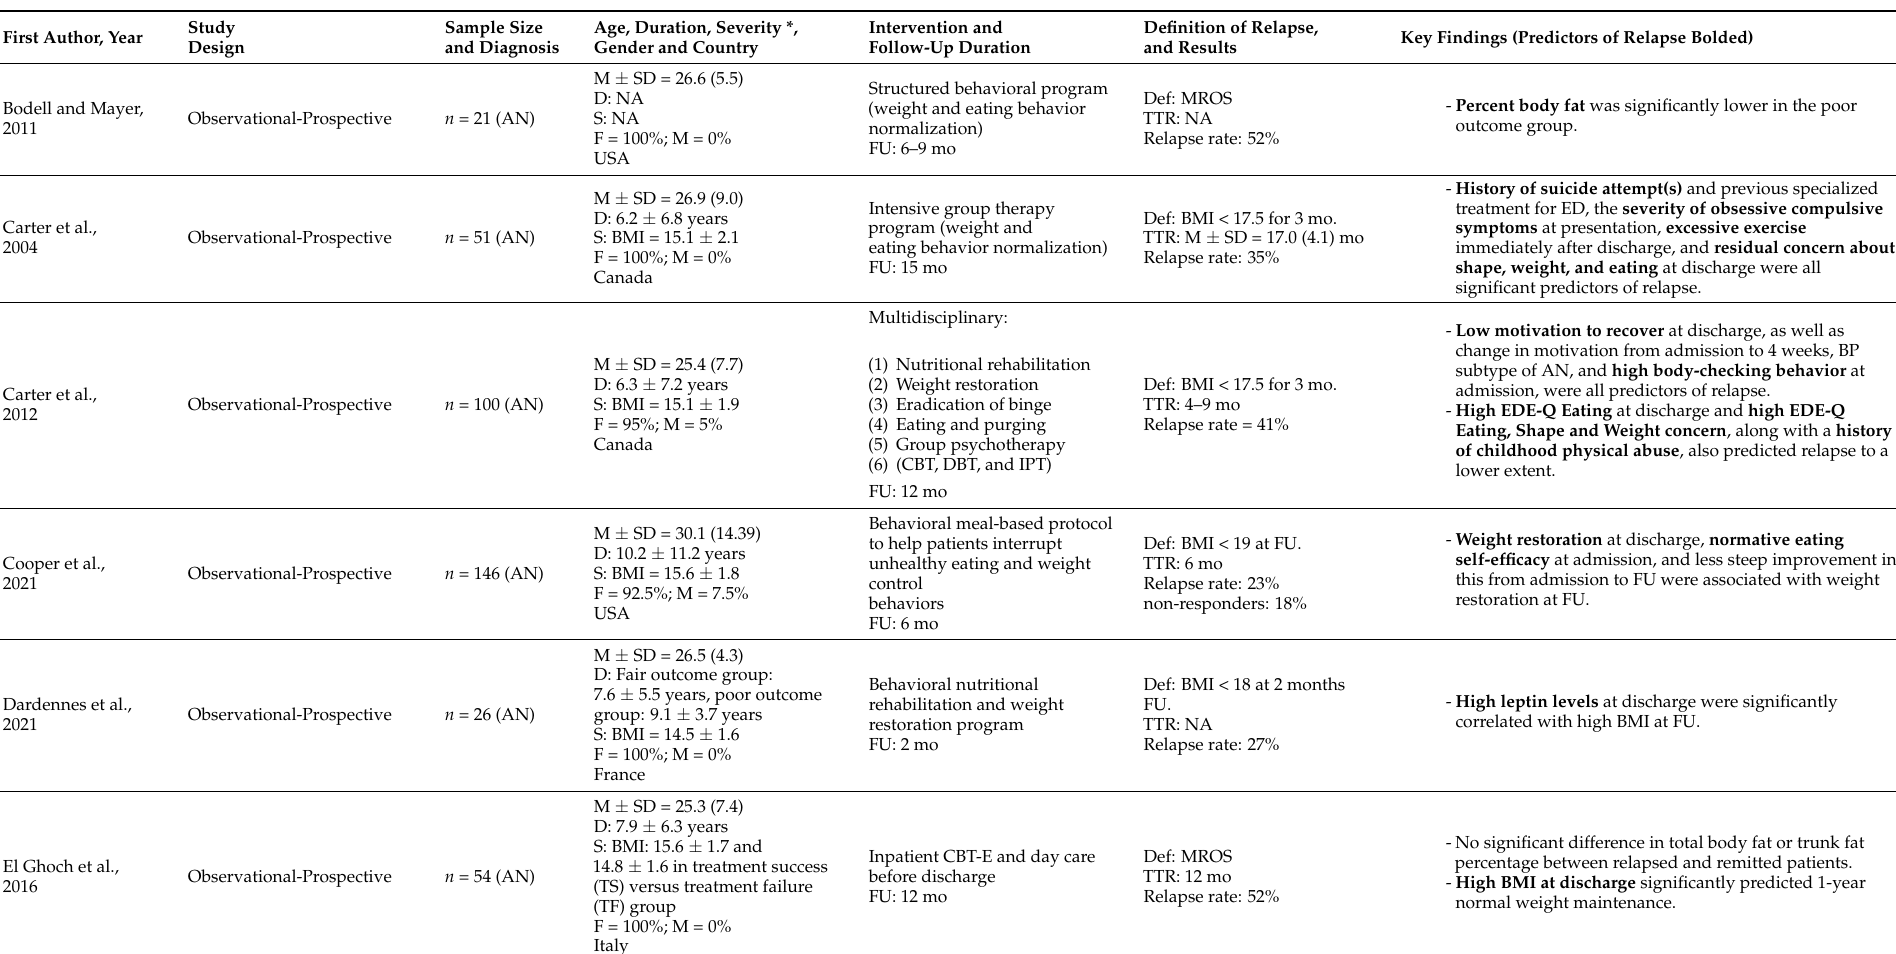
Table 1. Characteristics of included